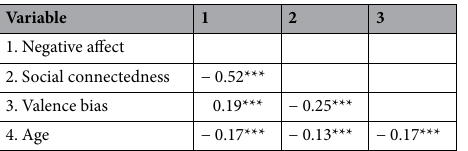
Table 2. Correlations among latent variables and age. ***p < 0.001 (two-tailed), **p < 0.01 (two-tailed), *p < 0.05